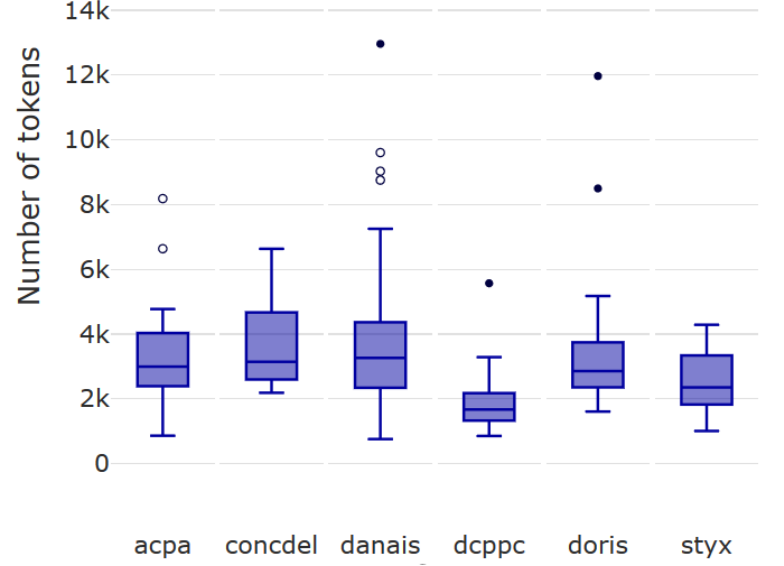
Figure 3. Distribution of the size of the decision by